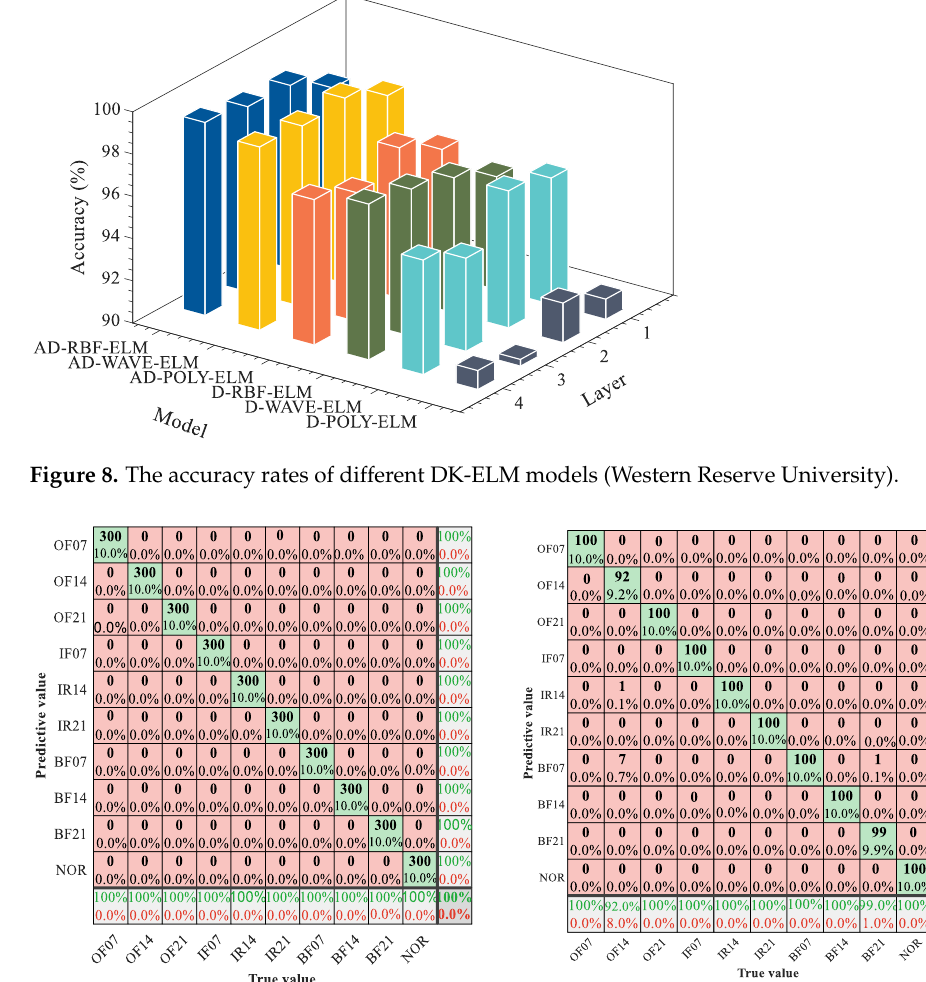
Table 4. Diagnostic rate of different models (Western Reserve